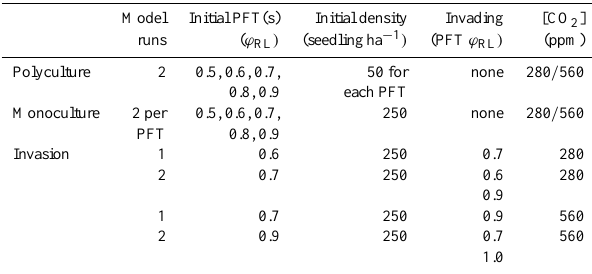
Table 3. Experimental design for model runs used to identify fine- root allocation strategies that are competitively optimal (evolution- arily stable strategies, ESSs) and that maximize wood production in monoculture. In these experiments, the plant functional types (PFTs) varied only in the ratio of fine-root surface area to leaf area ( ϕ RL ) . Because all PFTs shared the same target crown LAI, the pa- rameter ϕ RL primarily controls allocation to fine roots and wood. Model Initial